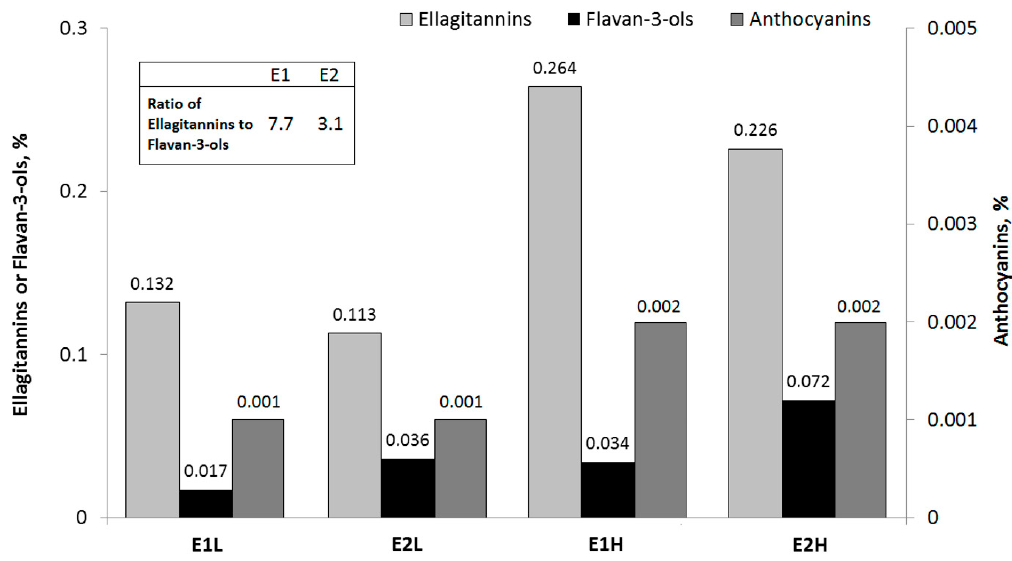
Figure 1. Concentration of polyphenols in diets with raspberry extracts. E1L, E2L were fed diet with low dosage of raspberry extracts characterized by different ratio of the ETs to flavan-3-ols (7.7 and 3.1 respectively); E1H, E2H were fed diet with high dosage of raspberry extracts characterized by different ratio of the ETs to flavan-3-ols (7.7 and 3.1 respectively); E1, diet with raspberry extract 1; E2, diet with raspberry extract 2.